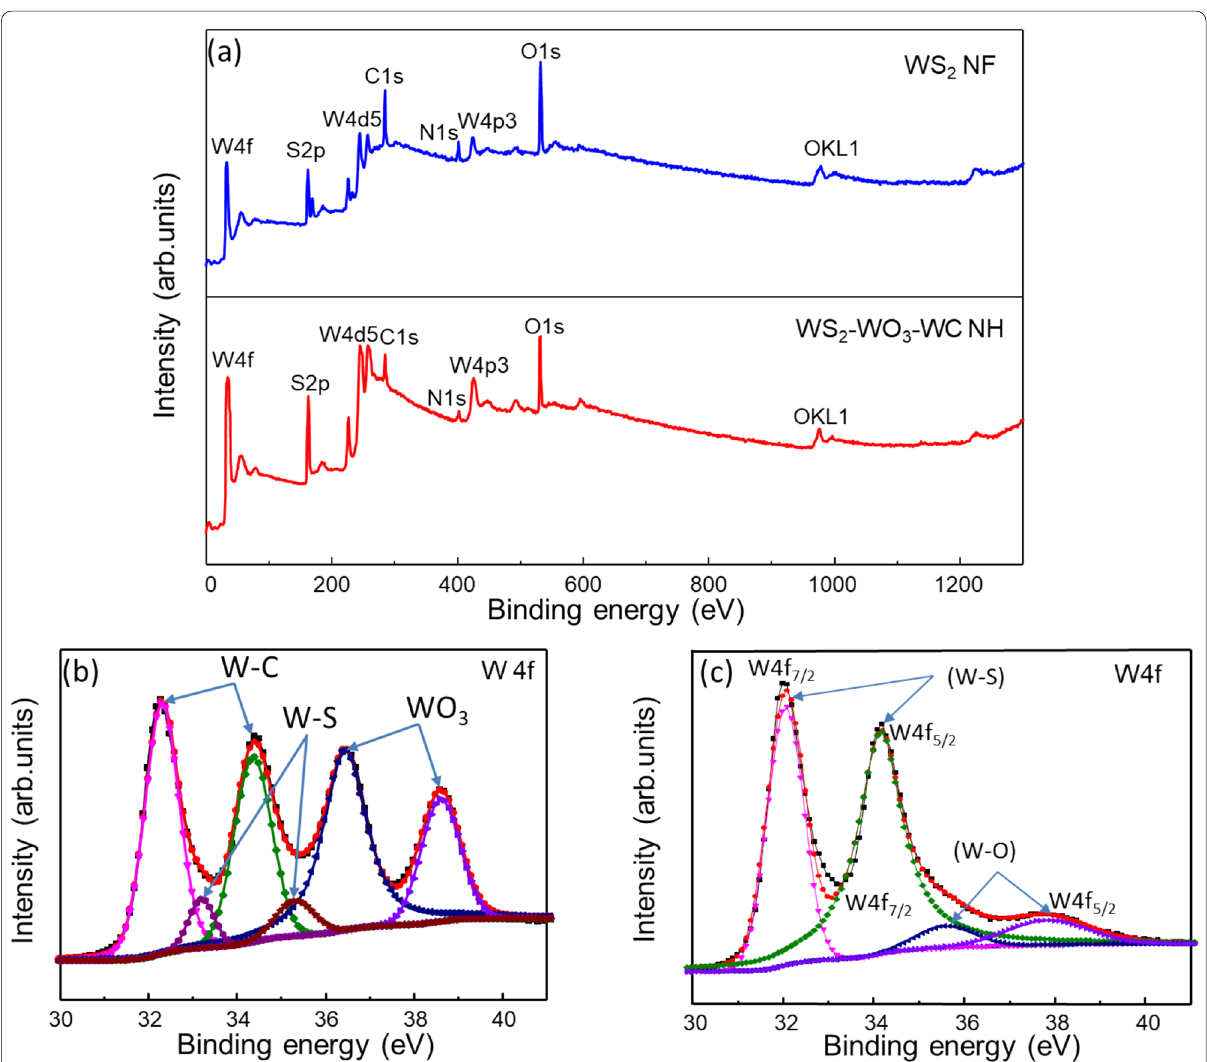
Fig. 4 a XPS survey profiles of the WS 2 –WC–WO 3 NH spheres and WS 2 NFs, high-resolution W4f XPS profiles of the b WS 2 –WC–WO 3 NH spheres and c WS 2